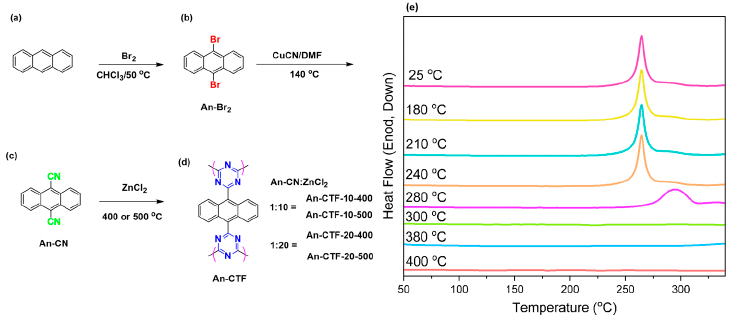
Figure 1. Preparation way and reaction conditions of An-Br 2 ( b ), An-CN ( c ), and An-CTFs ( d ) from An ( a ). ( e ) DSC profile of An-CN monomer at various thermal treatments from 25 to 400